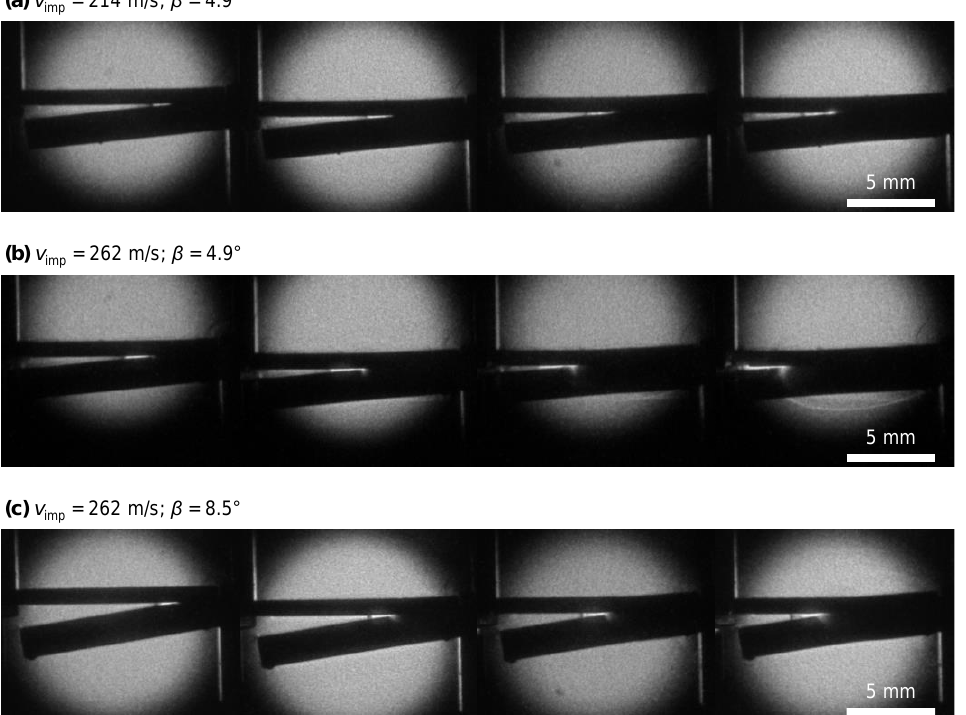
Figure 8. High-speed imaging of three different process parameter sets. The exposure time was 20 ns for all